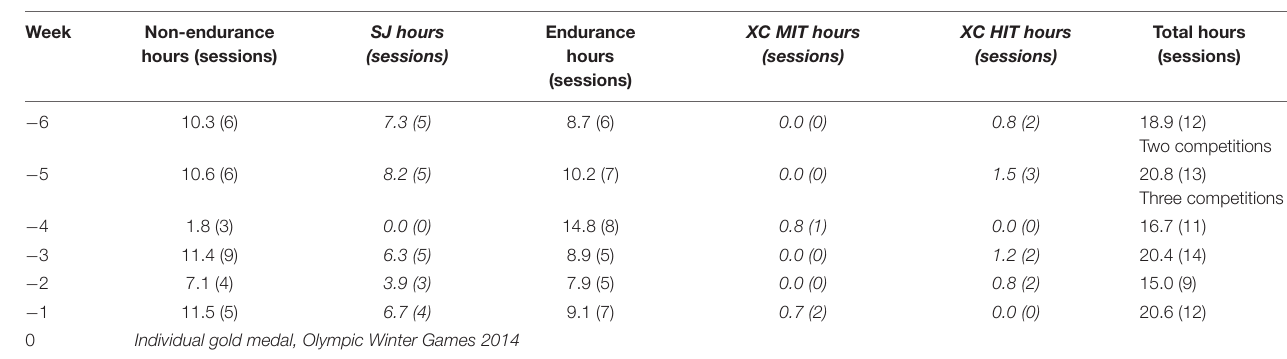
TABLE 3 | Weekly training content during the final 6 weeks (A) prior to winning two individual gold medals in the 2014 Sochi Winter Olympics, with detailed description of the training performed during the last 14 days (B) in an Olympic Nordic Combined champion. A Weekly training content during the final 6 weeks prior to gold medal Week